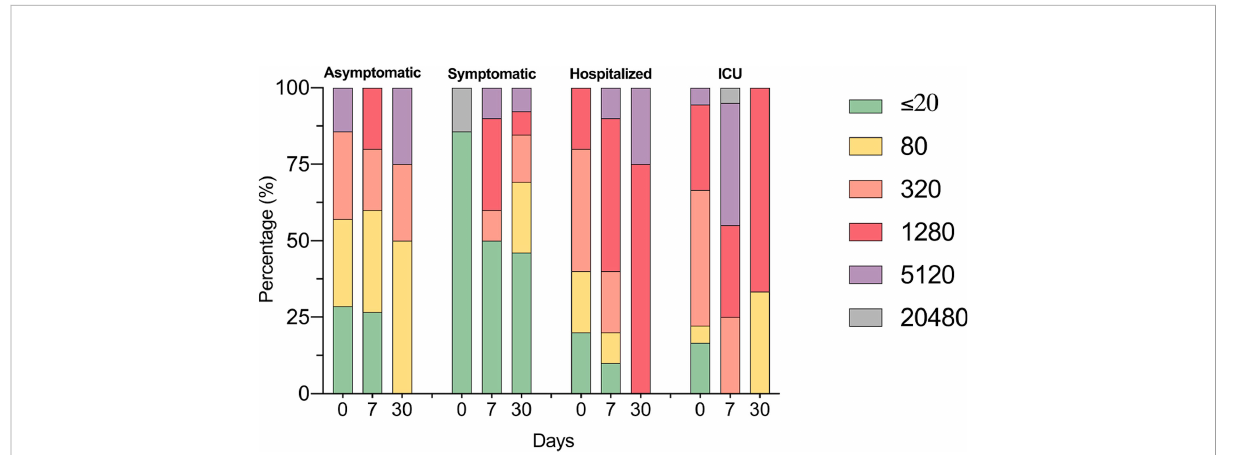
FIGURE 6 Identi fi cation of SARS-CoV-2 neutralizing antibodies. The bar graph shows the percentages of COVID-19 participants according to neutralizing antibodies titers by PNRT 50; follow-up for one